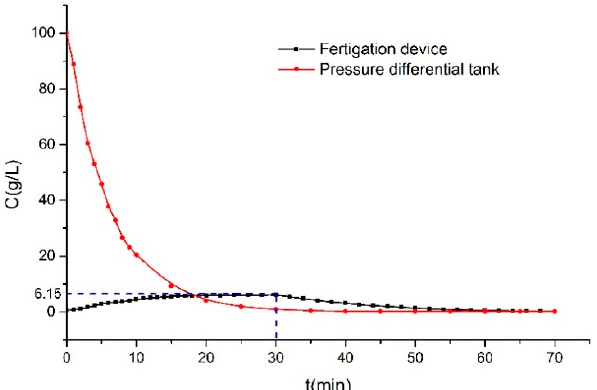
Figure 9. Fertilization concentration comparison between the fertigation device and the pressure differential tank.